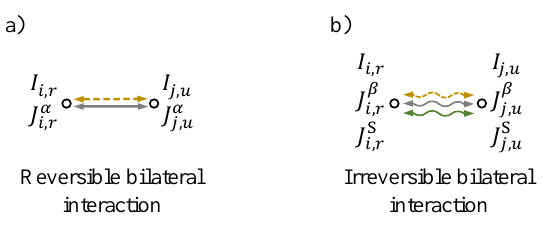
Figure 3. Schematics of bilateral interactions between the contact points r and u of subsystems i and j . The gold dashed arrows represent energy fluxes carried by gray fluxes of arbitrary extensities α , β and the green entropy flux. In the case of the irreversible interaction in ( b ), the multi-extensity flux necessarily includes an entropy flux, depicted by the green wavy